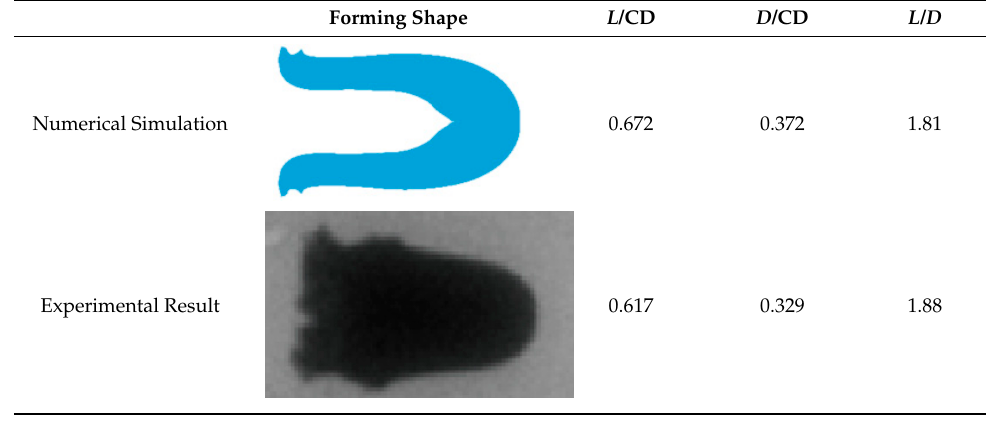
Table 8. Comparison of the copper EFP’s forming states in numerical simulation and the experiment results.